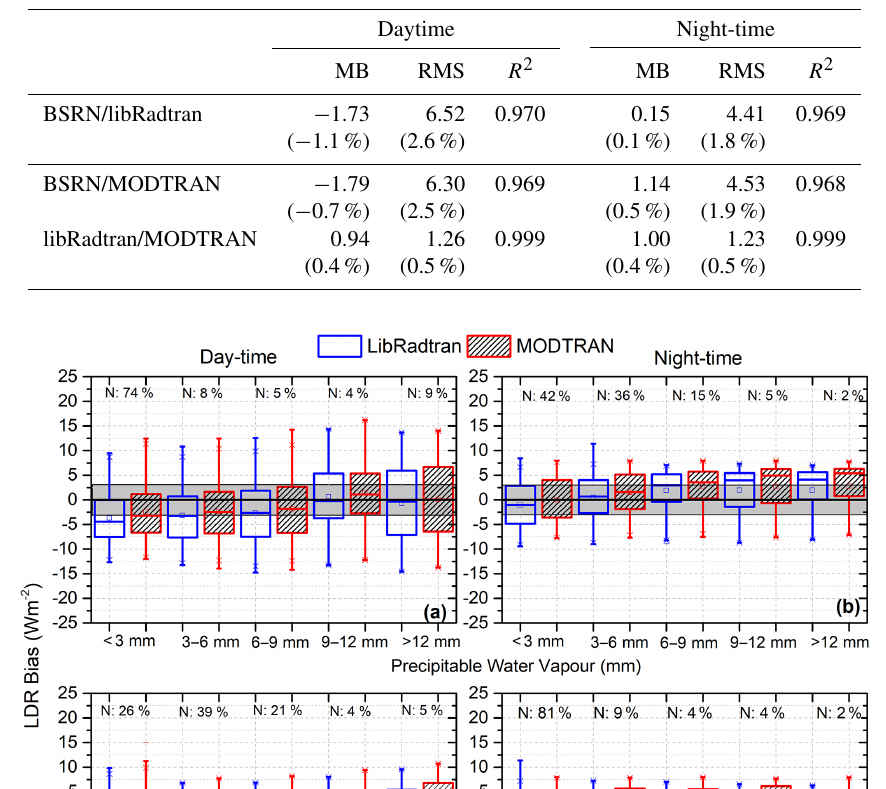
Table 4. Statistics for the LDR bias between libRadtran and MODTRAN simulations and BSRN LDR at IZO (in Wm − 2 ) performed with daytime (1048 cases) and night-time (1014 cases) data in the period 2010–2016 (MB, mean bias; RMS, root mean square of the bias; R 2 ). The statistics for the relative bias are in brackets (in %).